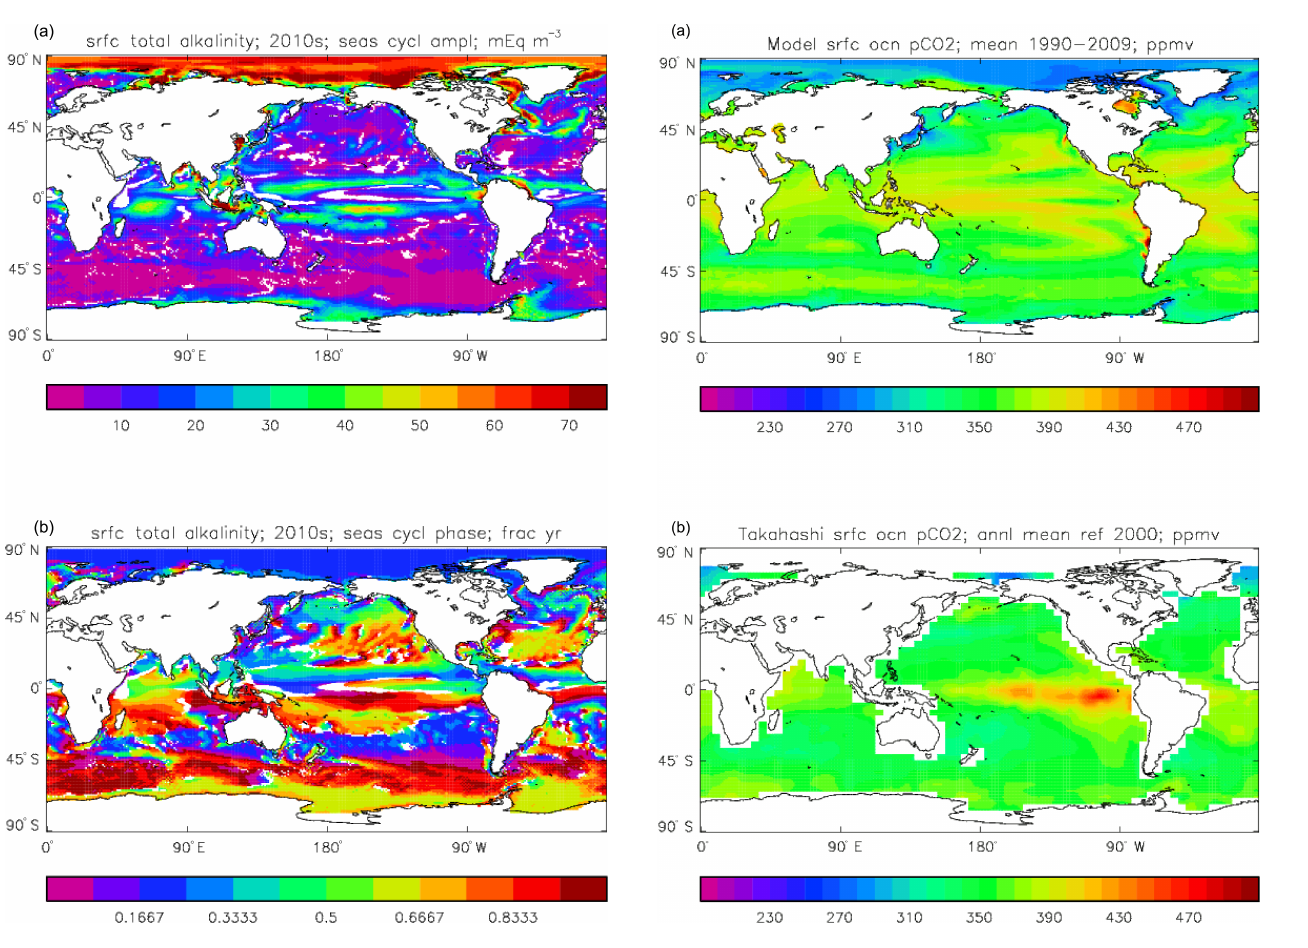
Figure 15. Surface ocean p CO 2 (ppmv): (a) model field averaged over the model years 1990–2009; (b) Takahashi gridded field from data; annual mean referenced to the year